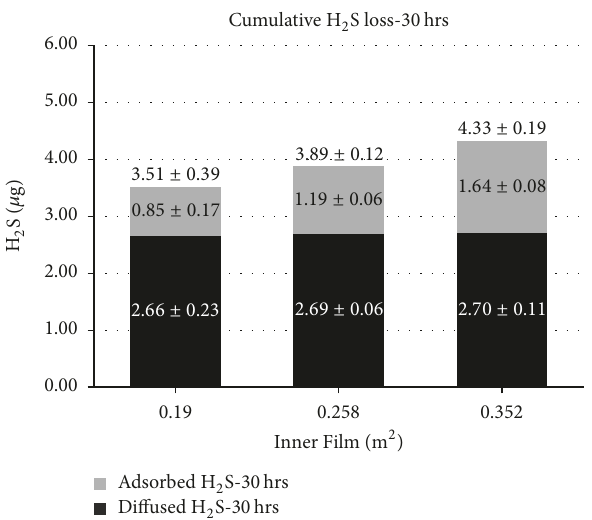
Figure7:TheamountofH 2 Sintermsofcumulativelosses,diffusion losses, and adsorption losses related to the surface of the inner film at a storage temperature of 23 ∘ C and humidity of 60%. The data reported are the average of the results from three different